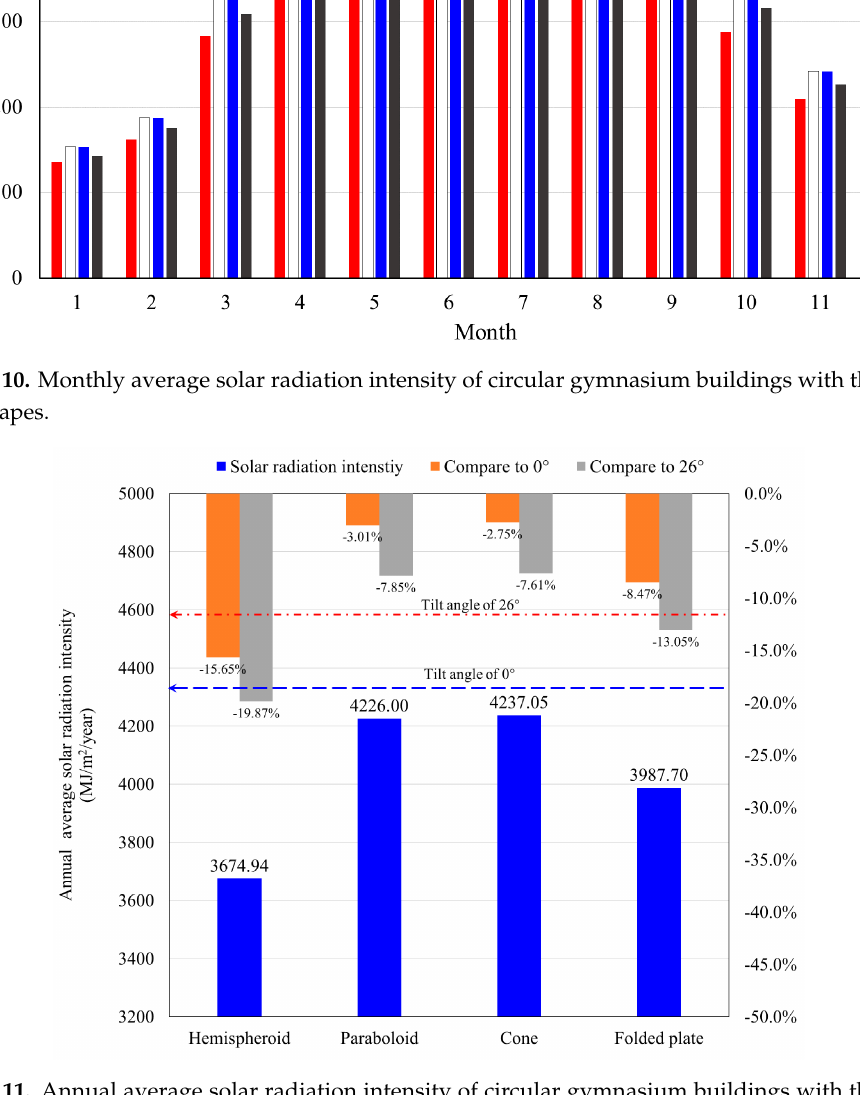
Figure 11. Annual average solar radiation intensity of circular gymnasium buildings with the four roof shapes.